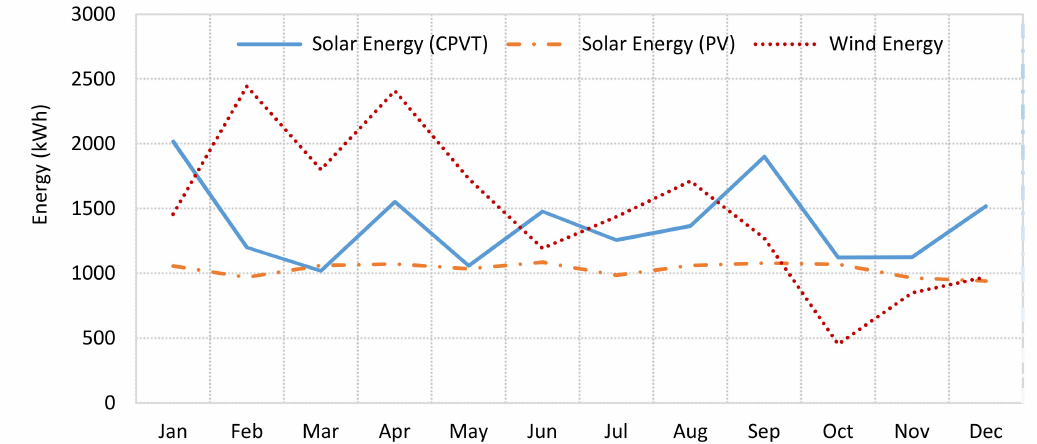
Figure 5. Selected PV, CPV / T and WT systems’ yearly energy production profiles in Qatar.